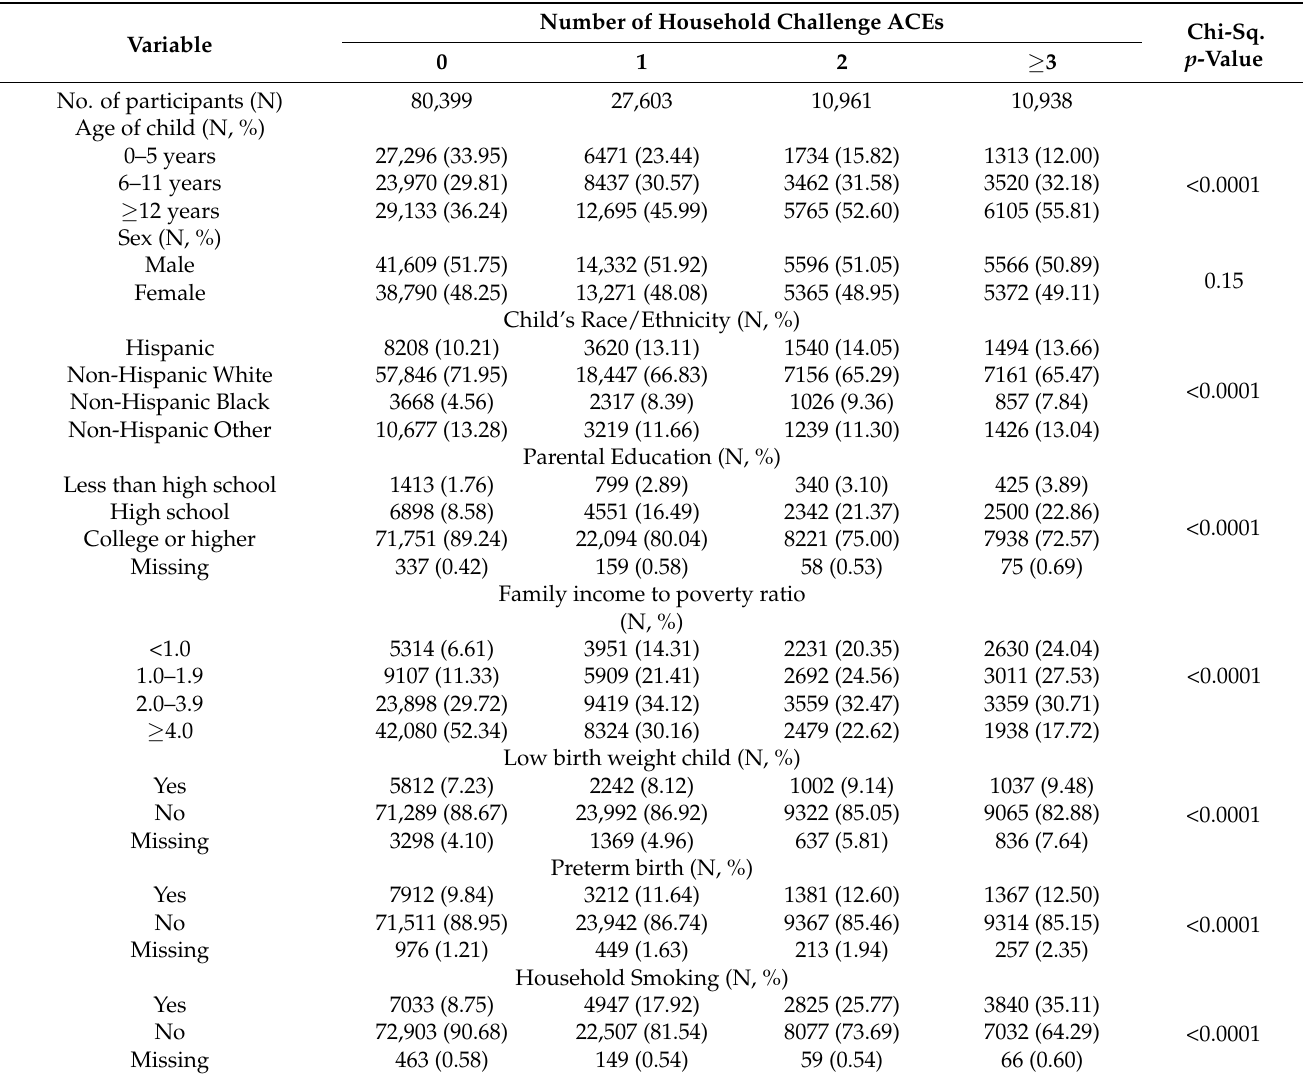
Table 2. Characteristics of the NSCH study population by ACE exposure, 2016–2019. Number of Household Challenge ACEs Chi-Sq. Variable